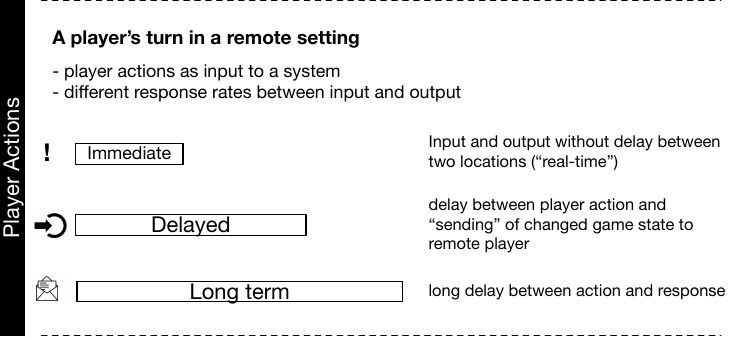
Figure 6. Different notions of timing and turn taking: a conceptual illustration of utilizing time delay in remote play related to a player’s turn and related input and response of a remote game